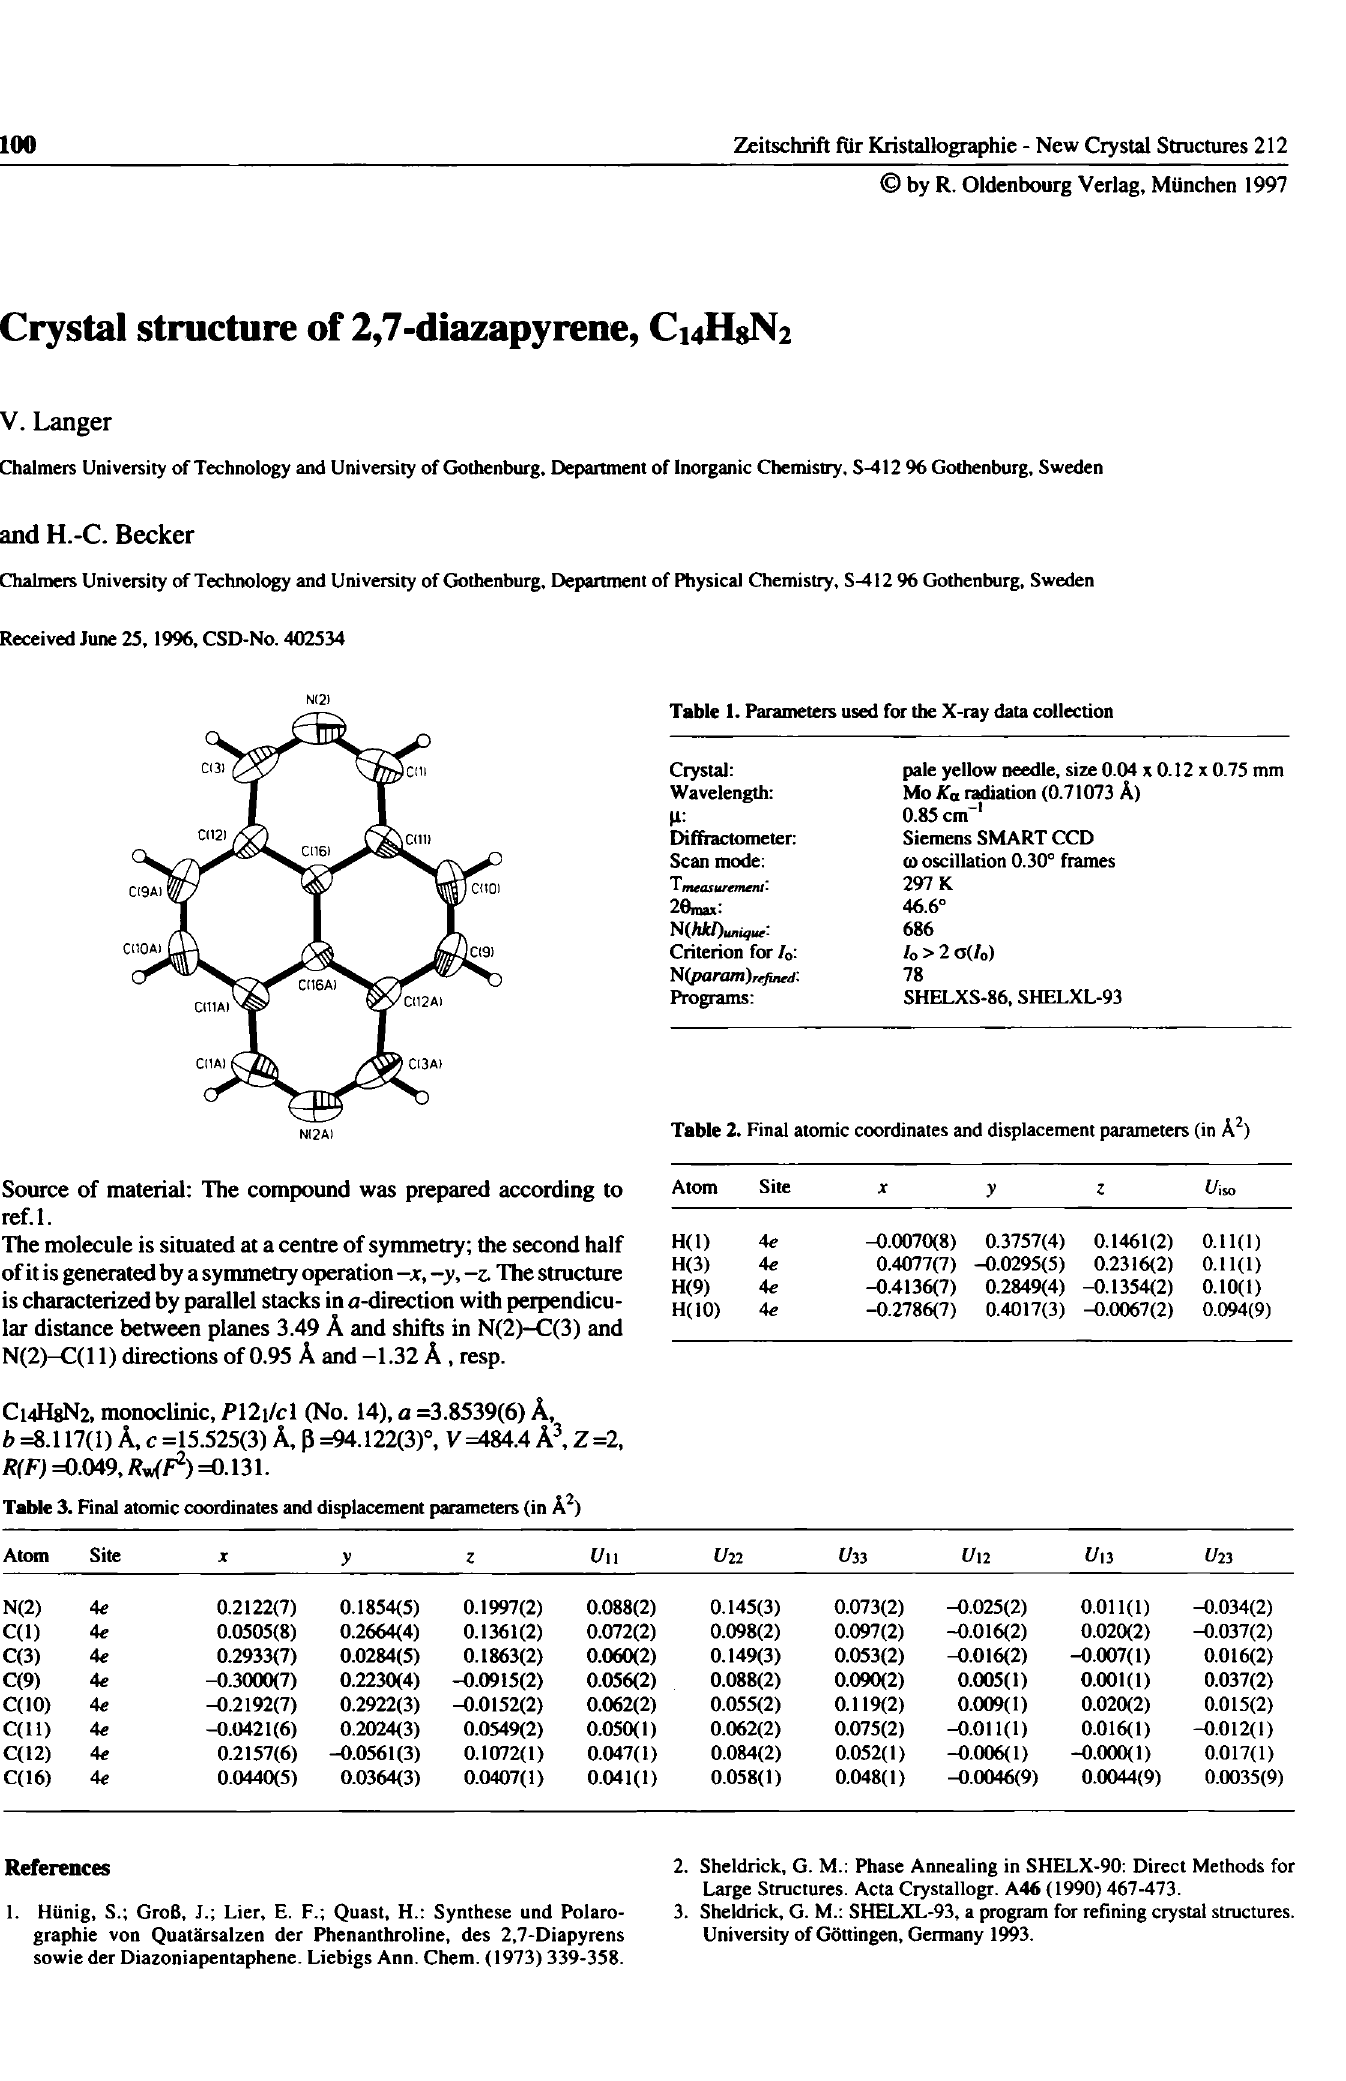
Table 3. Final atomic coordinates and displacement parameters (in Â 2 ) Atom